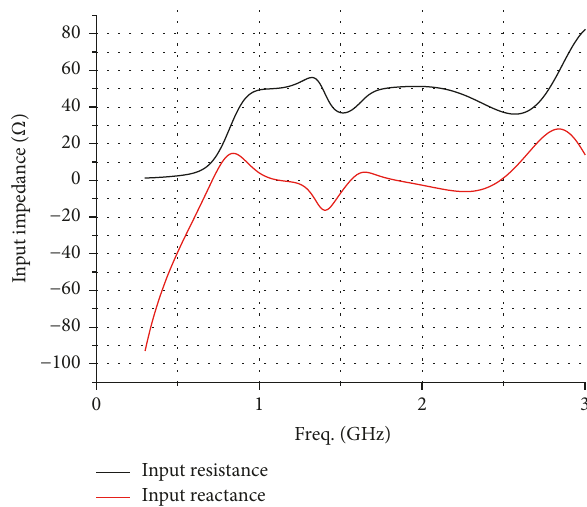
Figure 13: Input impedance of the antipodal Vivaldi antenna.